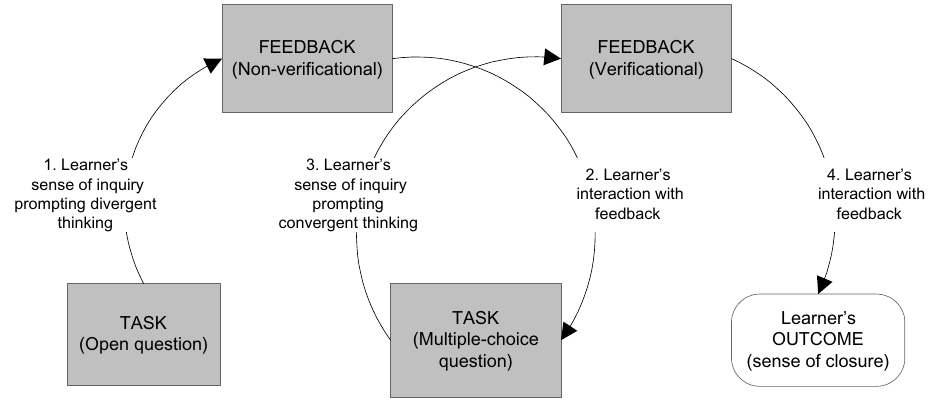
Figure 2. Proposed structure for divergent:convergent